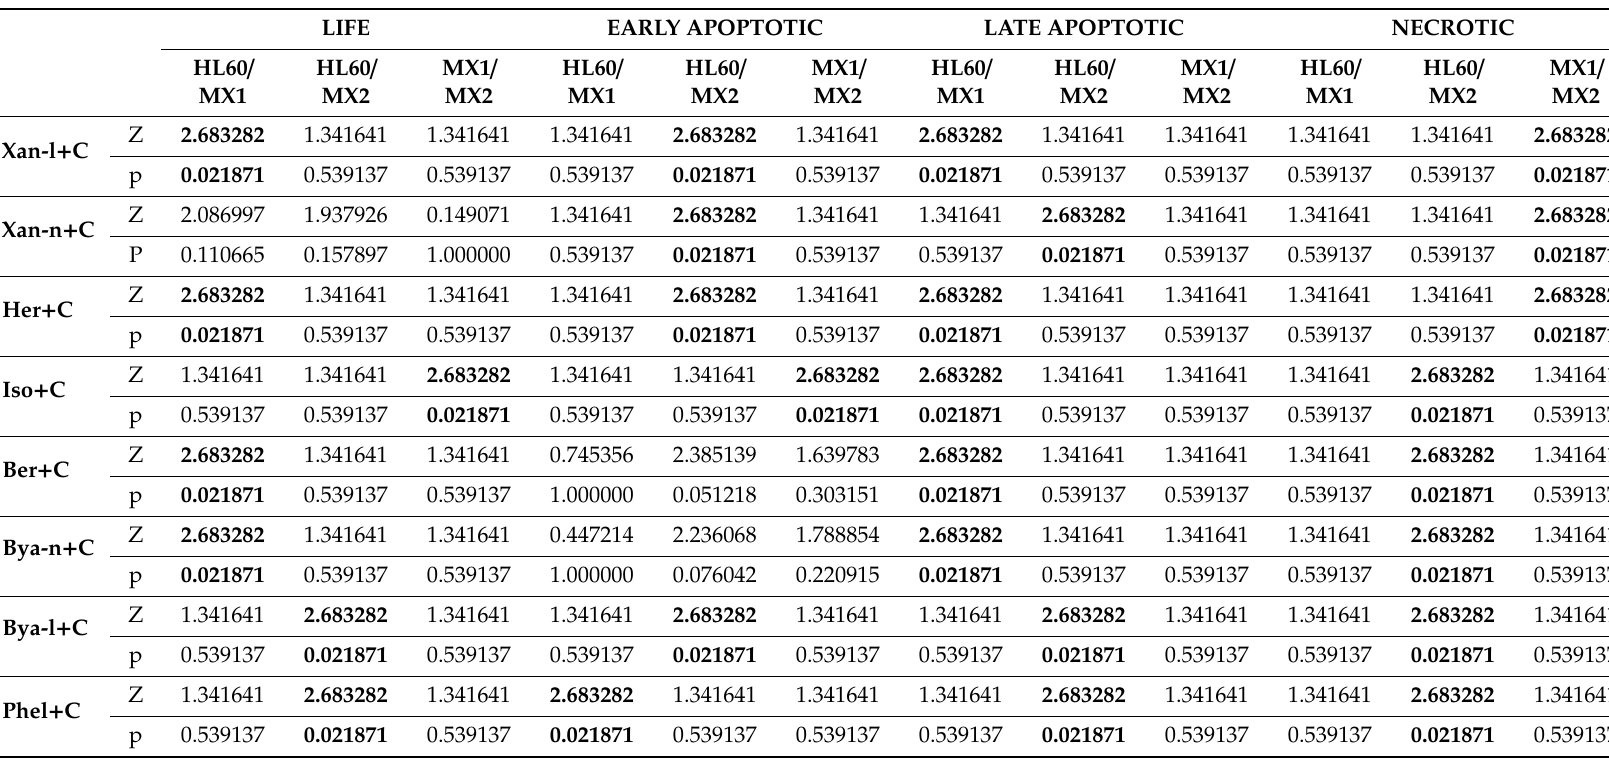
Table 4. Statistically significant di ff erences between the lines exposed to the tested furanocoumarin with the presence of mitoxantrone ( + C). Results of Kruskal–Wallis test: “Z” values for multiple comparisons, “ p ” values for multiple comparisons. The level of significance was set at p <